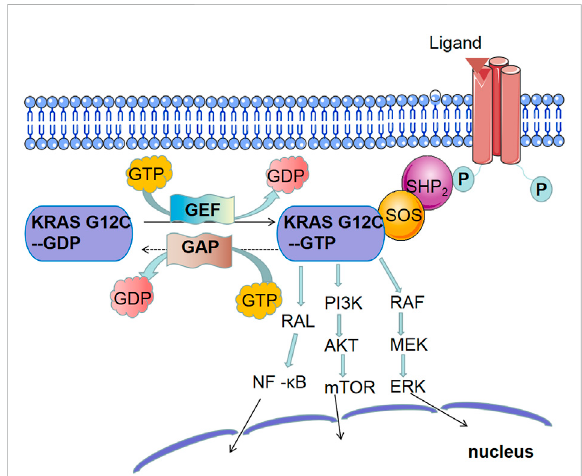
FIGURE 2 MainsignalingpathwayofKRASmutations: ① MAPKsignaling pathway: continuous activation of KRAS leads to the activation of RAF, the fi rst kinase in the mitogen-activated protein kinase (MAPK) pathway, which phosphorylates MEK and then activates extracellular signal-regulated kinase (ERK). ERK both activates the cytoplasmic matrix and is transported to the nucleus to stimulate the expression of multiple genes involved in cell proliferation, survival, differentiation, and cell cycle regulation. Extensive studies have shown that MAPK signaling pathway plays an important role in RAS-mediated tumorigenesis. ② PI3K signaling pathway: phosphatidylinositol-4, 5-diphosphate trikinase (PI3K) also plays a key role in RAS-mediated tumorigenesis. When KRAS is activated, PI3K converts phosphatidylinositol 4, 5-phosphate (PIP2) to phosphatidylinositol 3, 4, 5-triphosphate (PIP3) through phosphorylation, which activates phosphoinositol-dependent kinase 1 (PDK1) and phosphorylates AKT, a serine/threonine-speci fi c protein